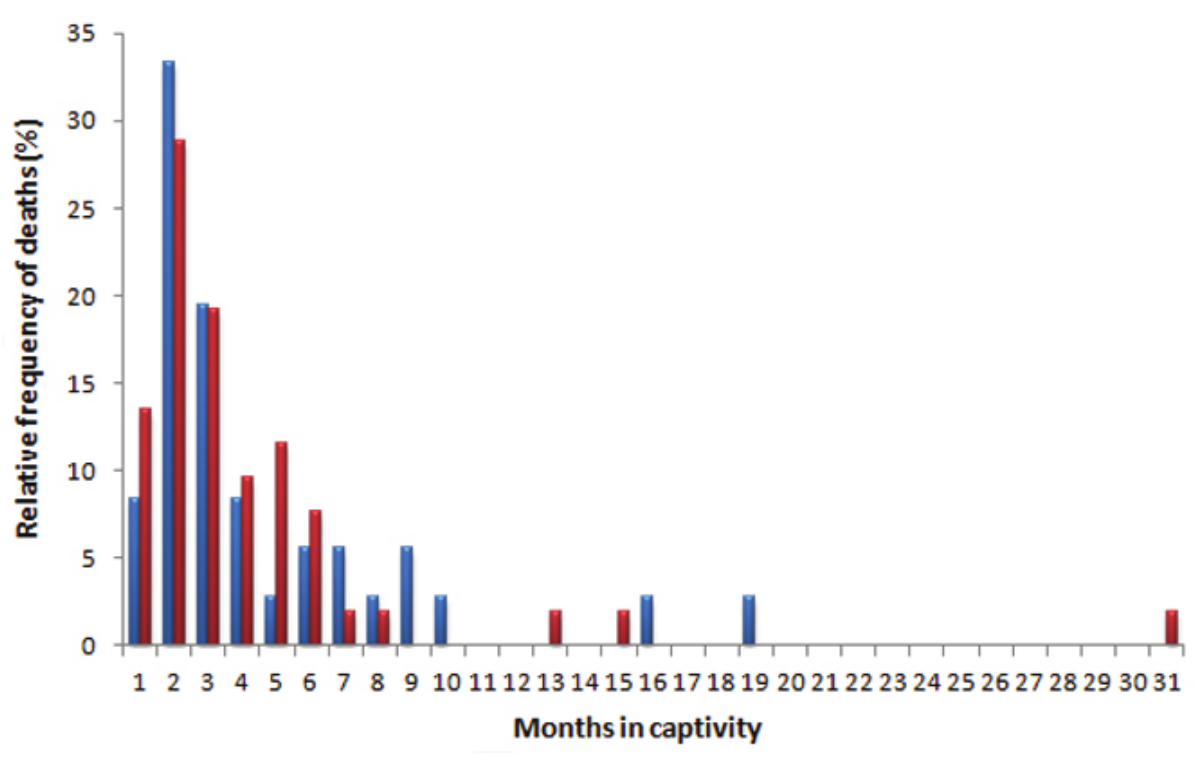
Figure 2. Relative monthly mortality frequencies for Philodryas olfersii (blue bars) and Philodryas patagoniensis (red bars) held in captivity for venom